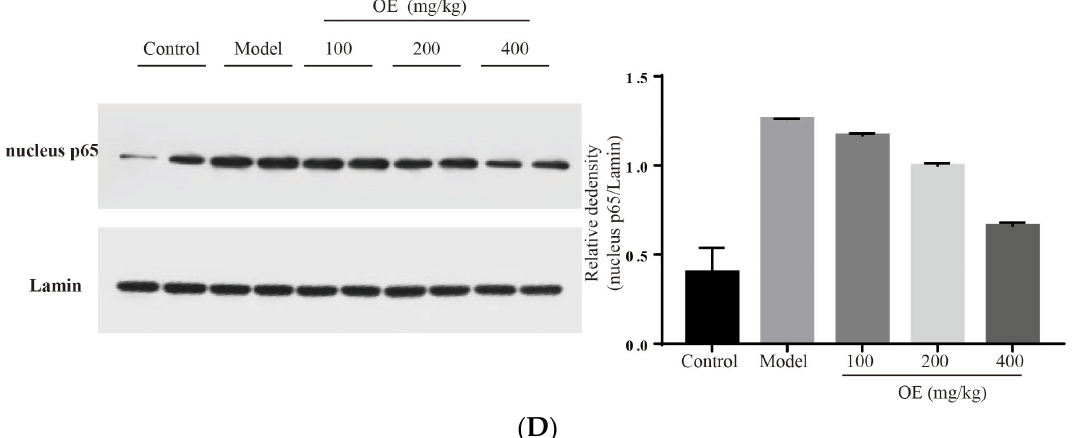
Figure 6. Effect of osthole on TLR4, NF-κB and MAPK signaling pathways. ( A ) TLR4 and MYD88, ( B ) P-p38, ( C ) p-JNK and ( D ) nucleus p65. All data are presented as the mean ± SEM.